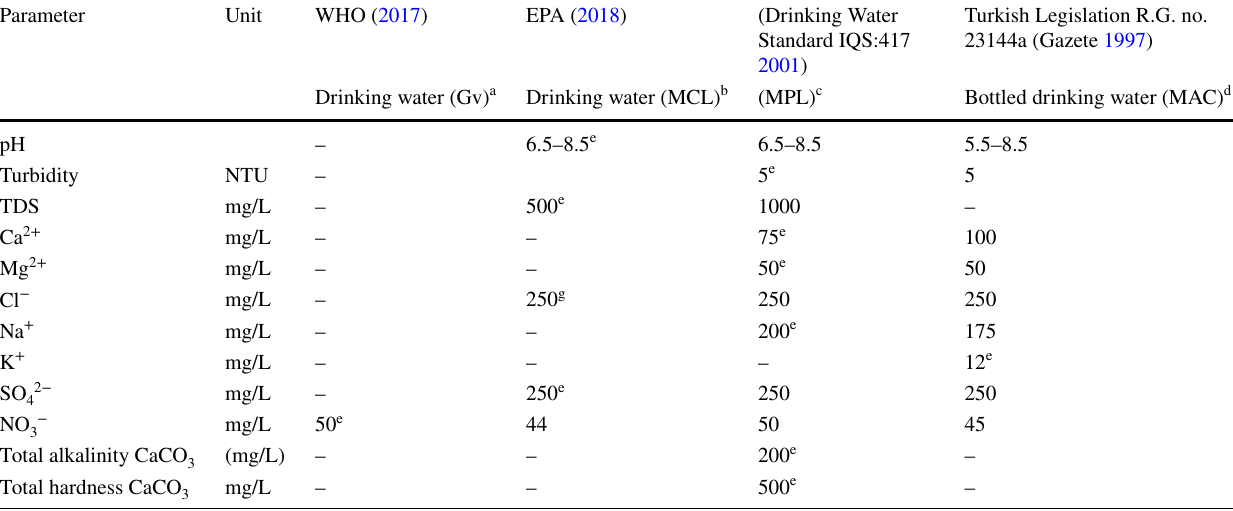
Table 3 National and international standards related to assessing the quality of spring water